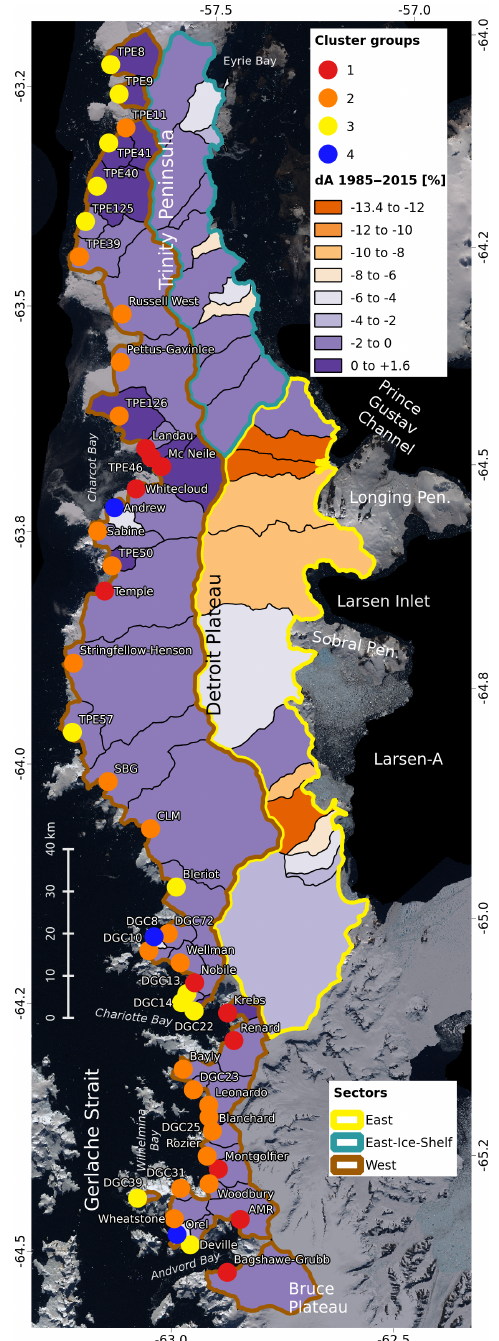
Figure 5. Spatial distribution of glacier types along the west coast. Glaciers are grouped based on a hierarchical cluster analysis (dots). In Sect. 5.3 the characteristics of the groups are discussed in detail. Individual glacier catchment colors indicate relative area change in the period 1985–2015. Colored polygon outlines indicate bound- aries of the three sectors. Background: Landsat LIMA Mosaic USGS, NASA, BAS,